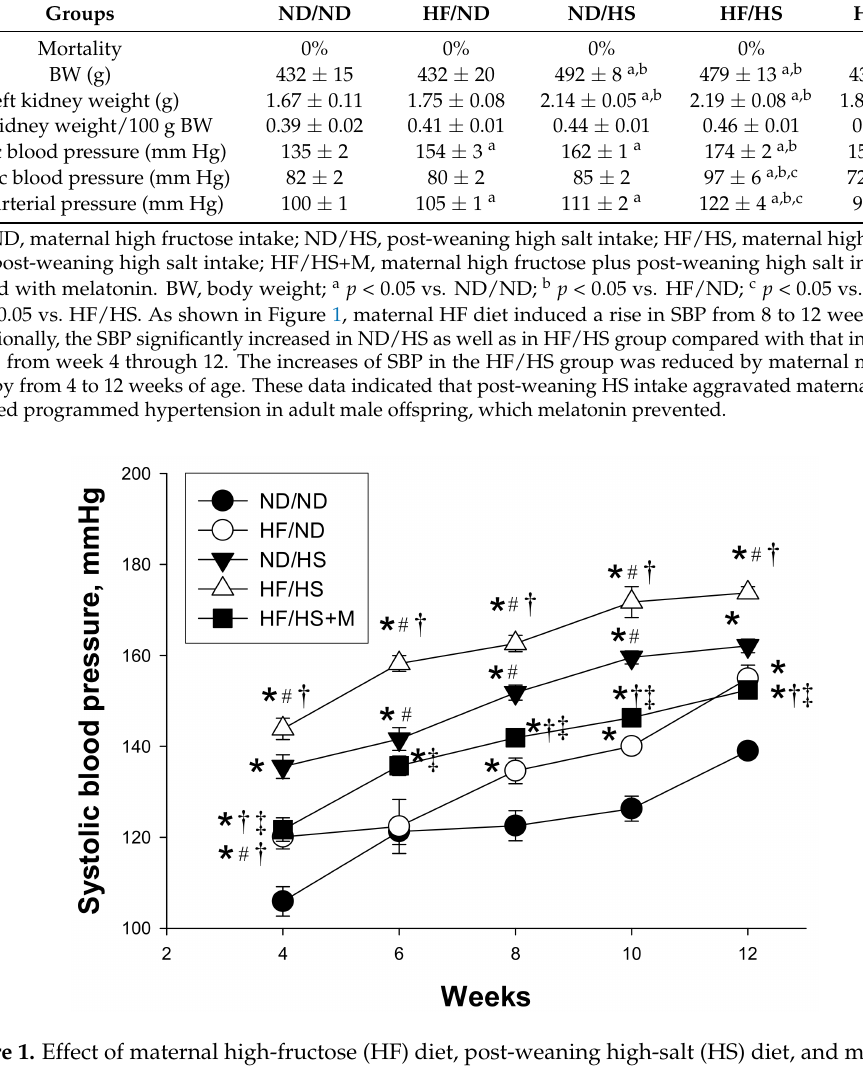
Figure 1. Effect of maternal high-fructose (HF) diet, post-weaning high-salt (HS) diet, and melatonin (M) on systolic blood pressure in 12-week-old male offspring. * p < 0.05 vs. ND/ND, # p < 0.05 vs. HF/ND, † p < 0.05 vs. ND/HS, ‡ p < 0.05 vs.